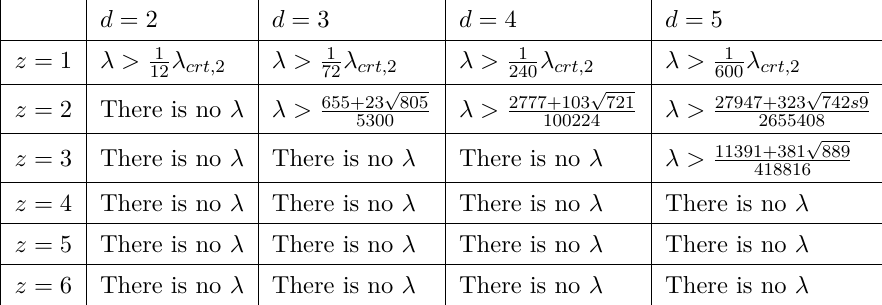
Table 3 . The appropriate ranges of the coupling constant λ for which w fB is a maximum outside the horizon. Here, λ is defined by eq. (3.52). crt, 2